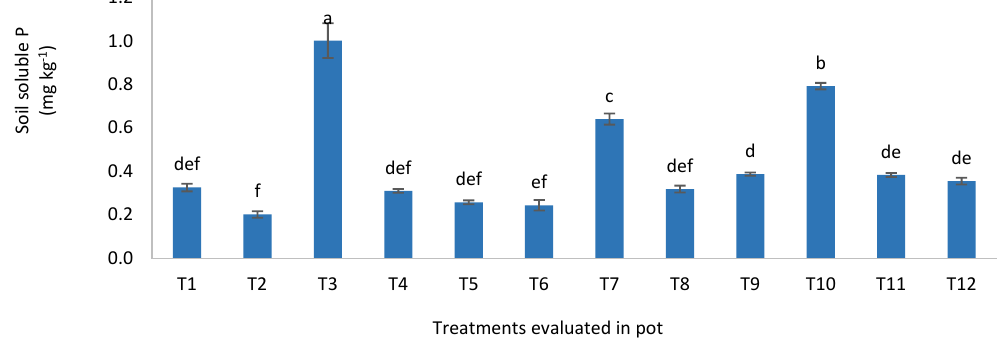
Figure 11. E ff ects of treatments on soil soluble phosphorus. Di ff erent letters indicate significant Figure 11. Effects of treatments on soil soluble phosphorus. Different letters indicate significant di ff erence between means using Tukey’s HSD (Honestly Significant Di ff erence) test at p ≤ 0.05. The difference between means using Tukey’s HSD (Honestly Significant Difference) test at p ≤ 0.05. The error bars are the ± standard error of triplicates. error bars are the ± standard error of triplicates.